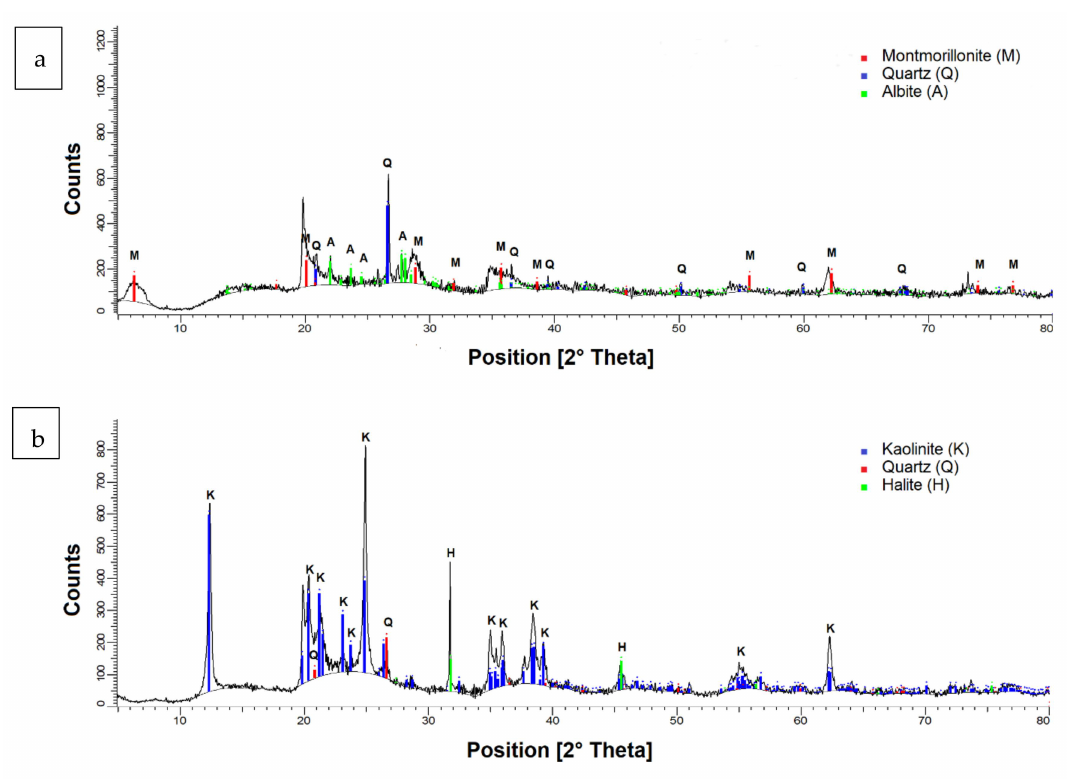
Figure 4. Diffractograms ( a ) sodium montmorillonite and ( b )